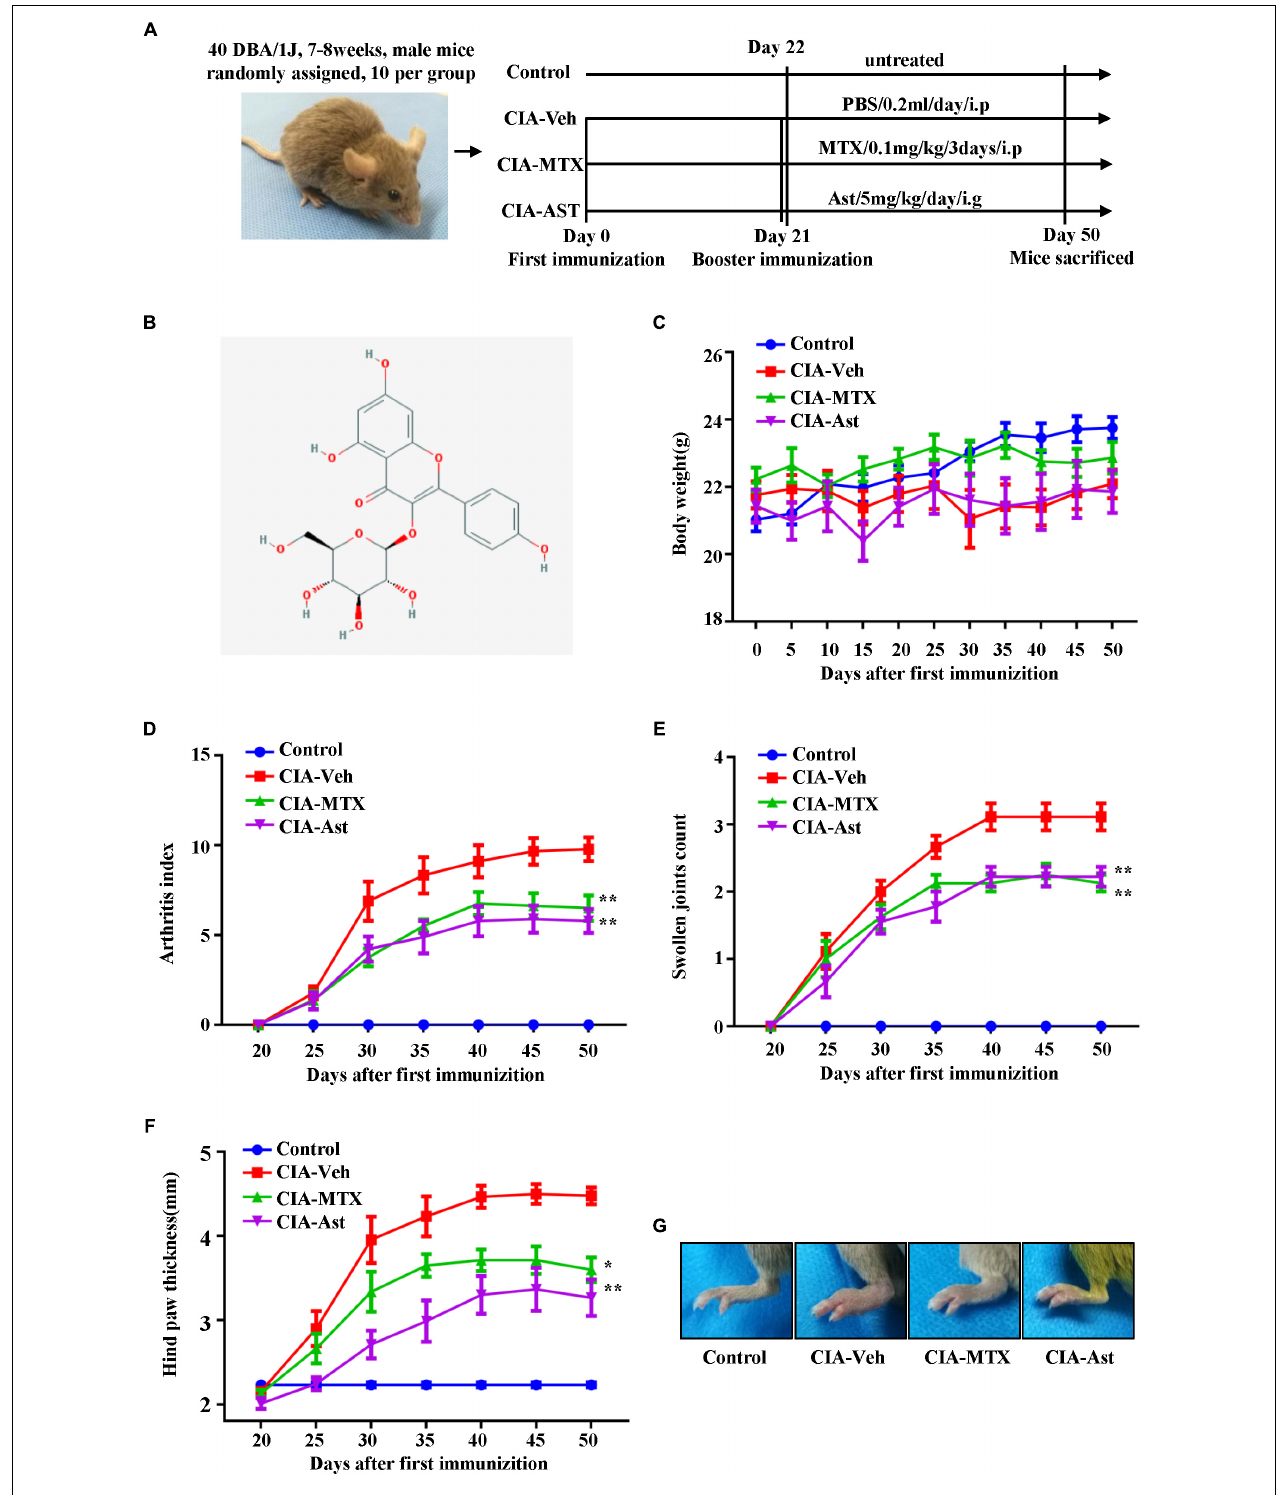
FIGURE 1 | Astragalin attenuated the symptoms of CIA mice. The time diagram of the process of CIA induction and treatment (A) . The chemical structure of astragalin (B) . Mice with established CIA were injected either with PBS or 0.1 mg/kg/3 day MTX intraperitoneally or with oral dose of astragalin 5 mg/kg/day after day 21 booster immunization. The body weight (C) , arthritis index (D) , swollen joints count (E) , and hind paw thickness (F) were scored and recorded every 5 days in a blinded manner. The representative pictures of the hind paws of CIA mice (G) . Results are shown as mean ± SEM of ten mice per group. ∗ p < 0.05, ∗∗ p < 0.01 versus CIA-Veh